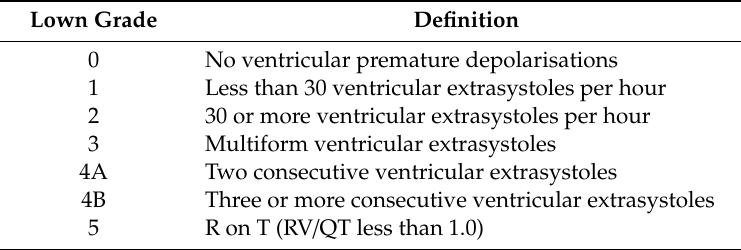
Table 1. The Lown grading system for ventricular